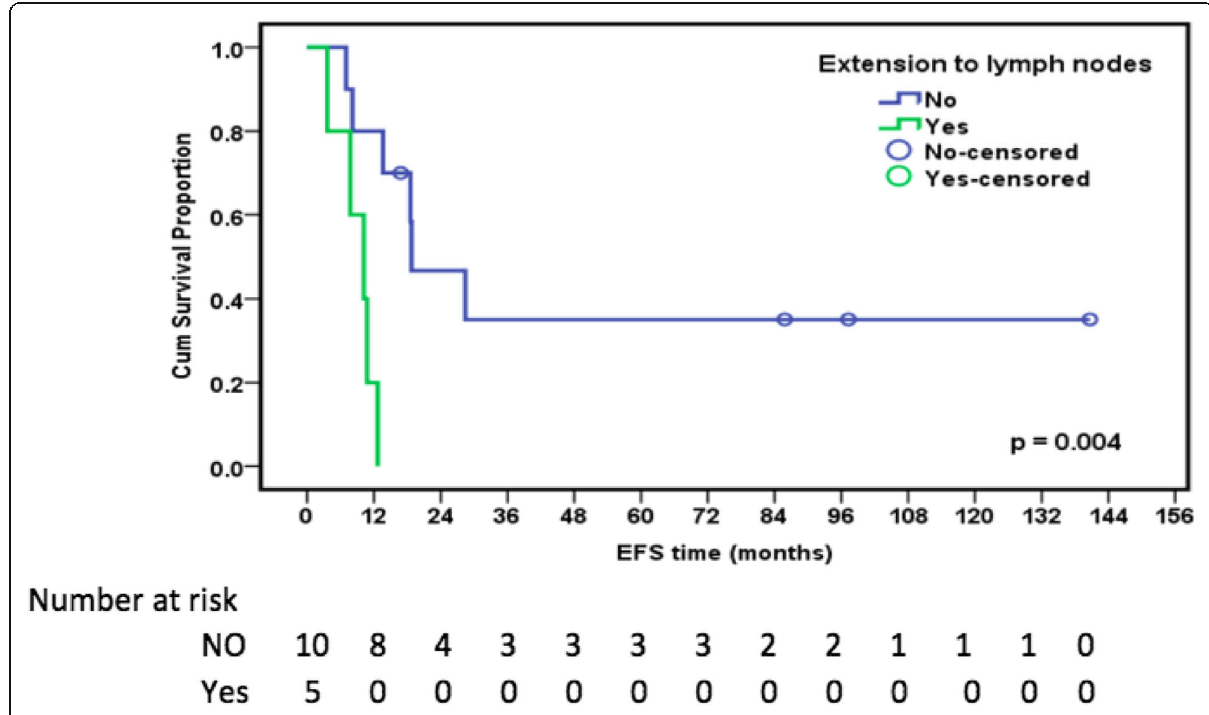
Fig. 3 Impact of lymph node extension on EFS among relapse stage III Wilms ’ tumor